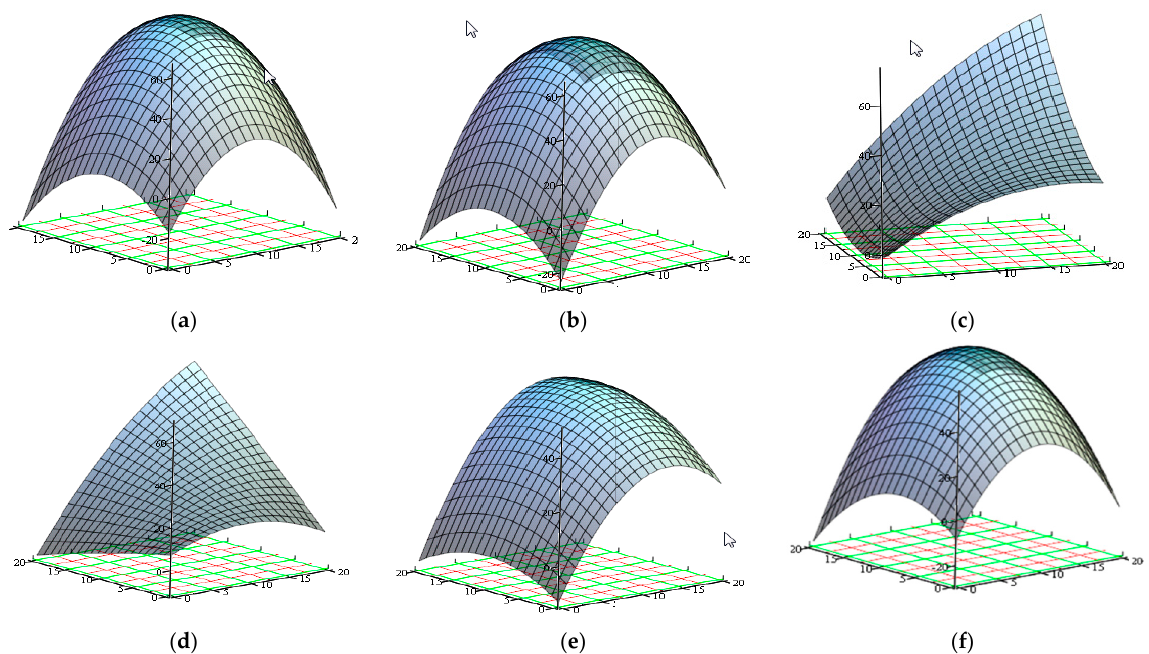
Figure 2. The 3D surface plots of degrees of broiler chicken gizzards hydrolysis as a function of factors—when treated with Propionix LCSC: ( a ) interactions of temperature and time of hydrolysis on DH; ( b ) interactions of temperature and the amount of starter culture; ( c ) interactions of the amount of starter culture and hydrolysis time on DH; when treated with BLC: ( d ) interactions of temperature and time of hydrolysis on DH; ( e ) interactions of temperature and the amount of starter culture; ( f ) interactions of the amount of starter culture and hydrolysis time on DH. DH = degrees of hydrolysis.